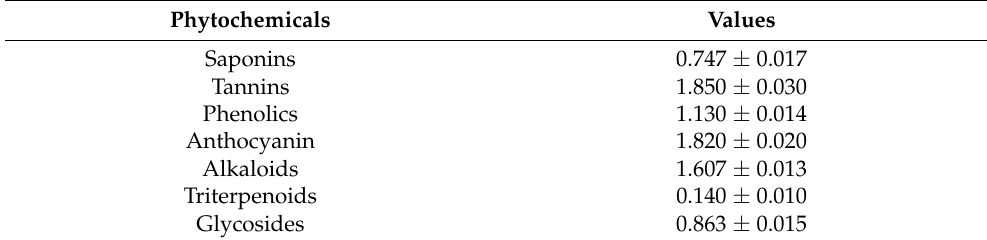
Table 1. Phytochemical constituents of methanolic P. amarus leaf extract.